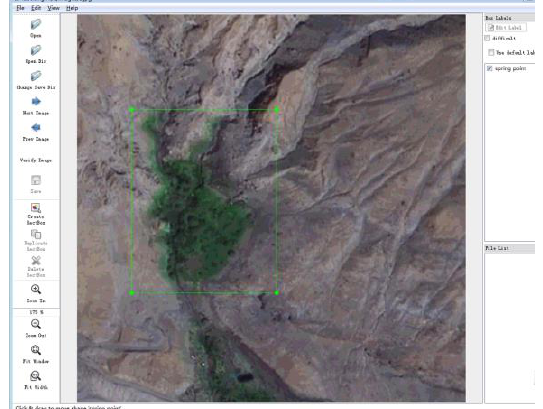
Figure1. Data set